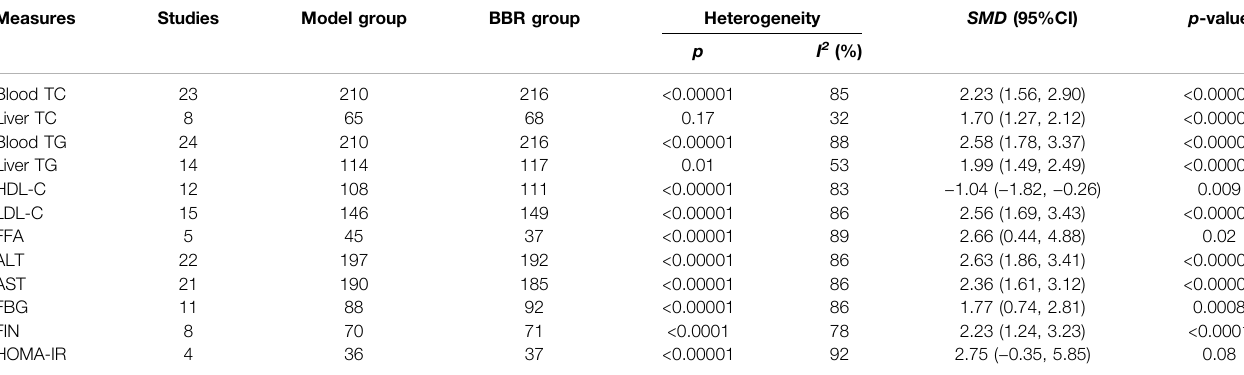
TABLE 1 | Comparison of major outcome measures of RUT treatment for NAFLD/NASH.